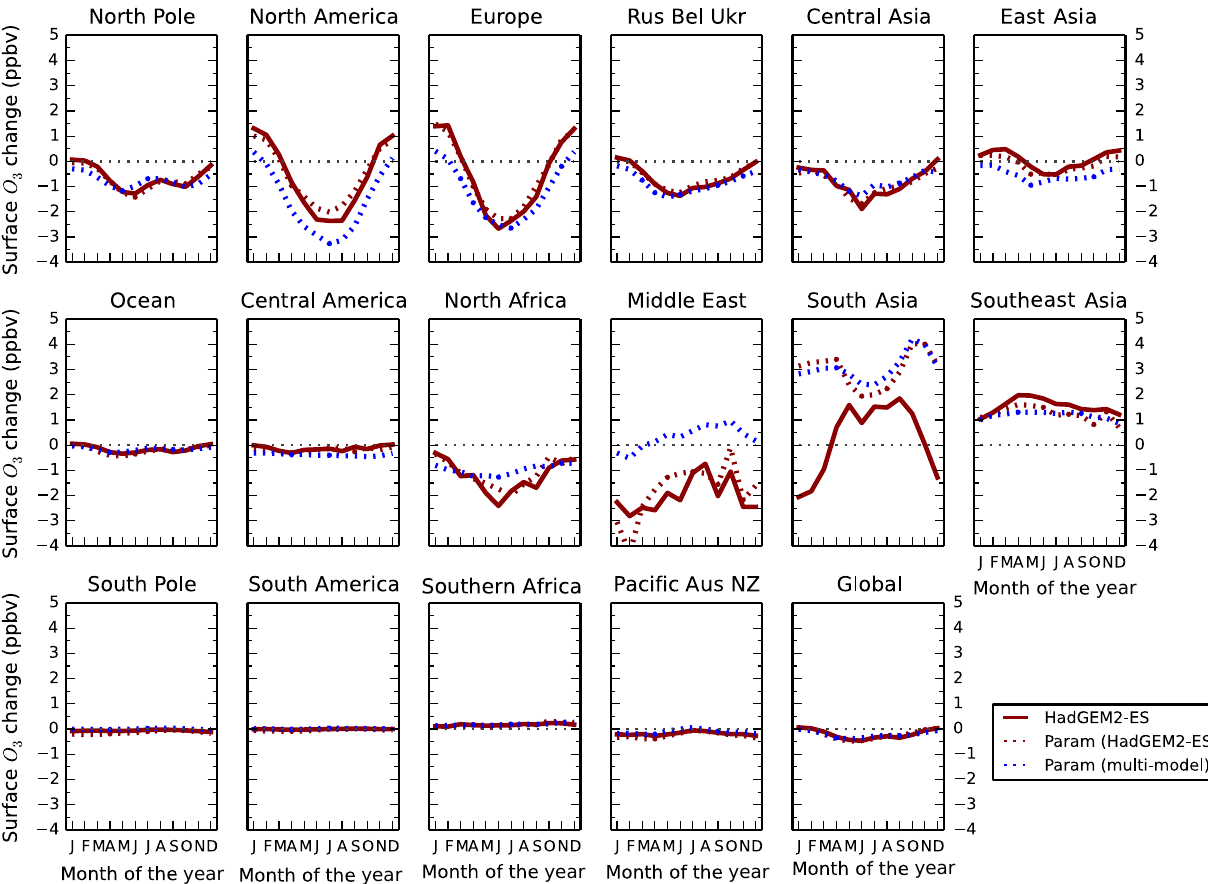
Figure 3. Monthly mean regional surface O 3 changes between 2010 and 2030 for the ECLIPSE V5a CLE scenario in HadGEM2-ES (red) and the parameterised response based on only HadGEM2-ES inputs (red dashed) and multiple model inputs (blue